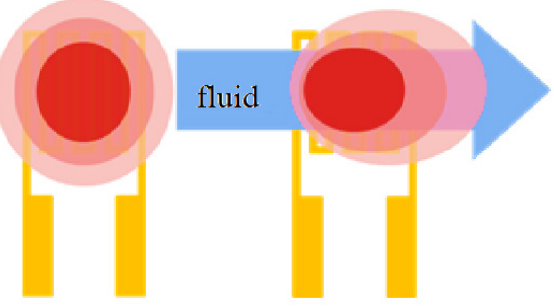
Figure 5. Schematic diagram of principle of hot-wire micro flow sensor.